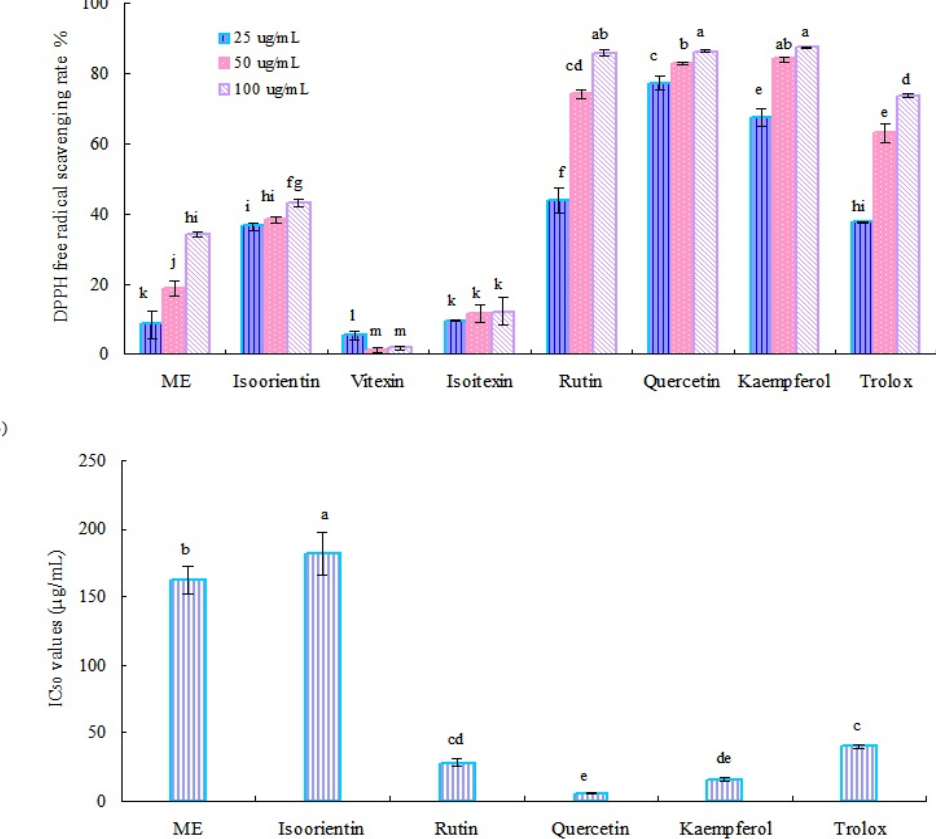
Figure 3. DPPH radical scavenging rate ( A ) and IC 50 values ( B ) of the methanol extract of Tartary buckwheat sprouts and six main flavonoids. Different letters (i.e., a–m) in each column indicated significant differences among the treatment samples, at p = 0.05 level.